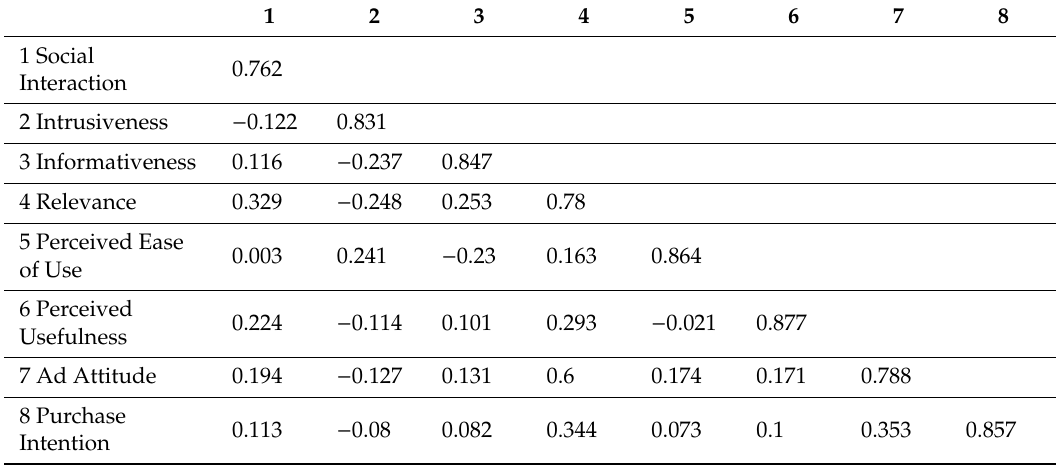
Table 5. Correlations between constructs (AVE and squared